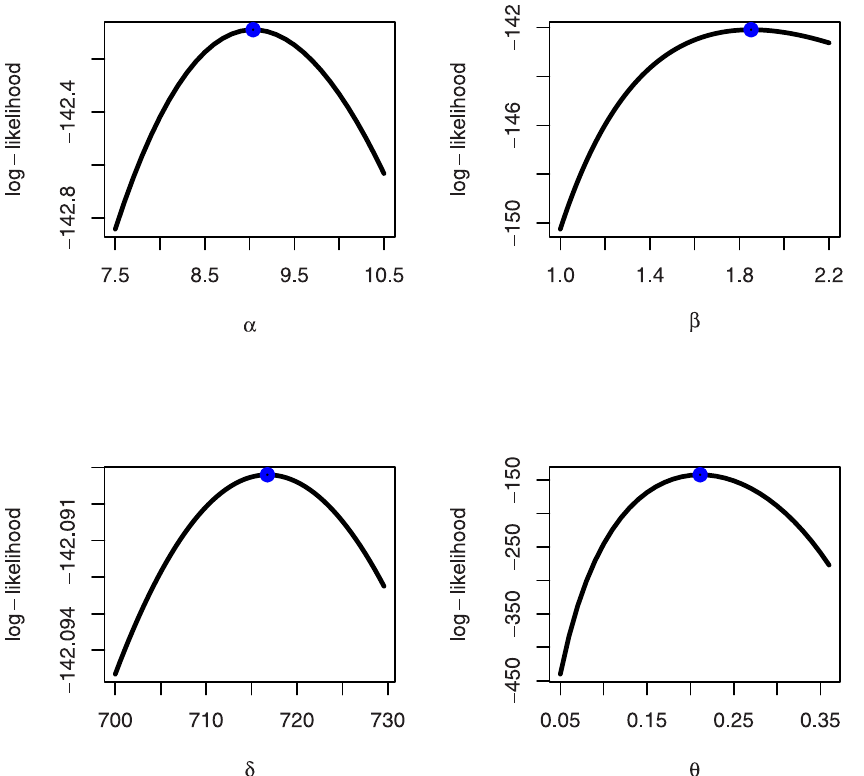
Fig 10. Log-likelihood value with parameters values of the OLINH distribution for COVID-19 vaccination data.